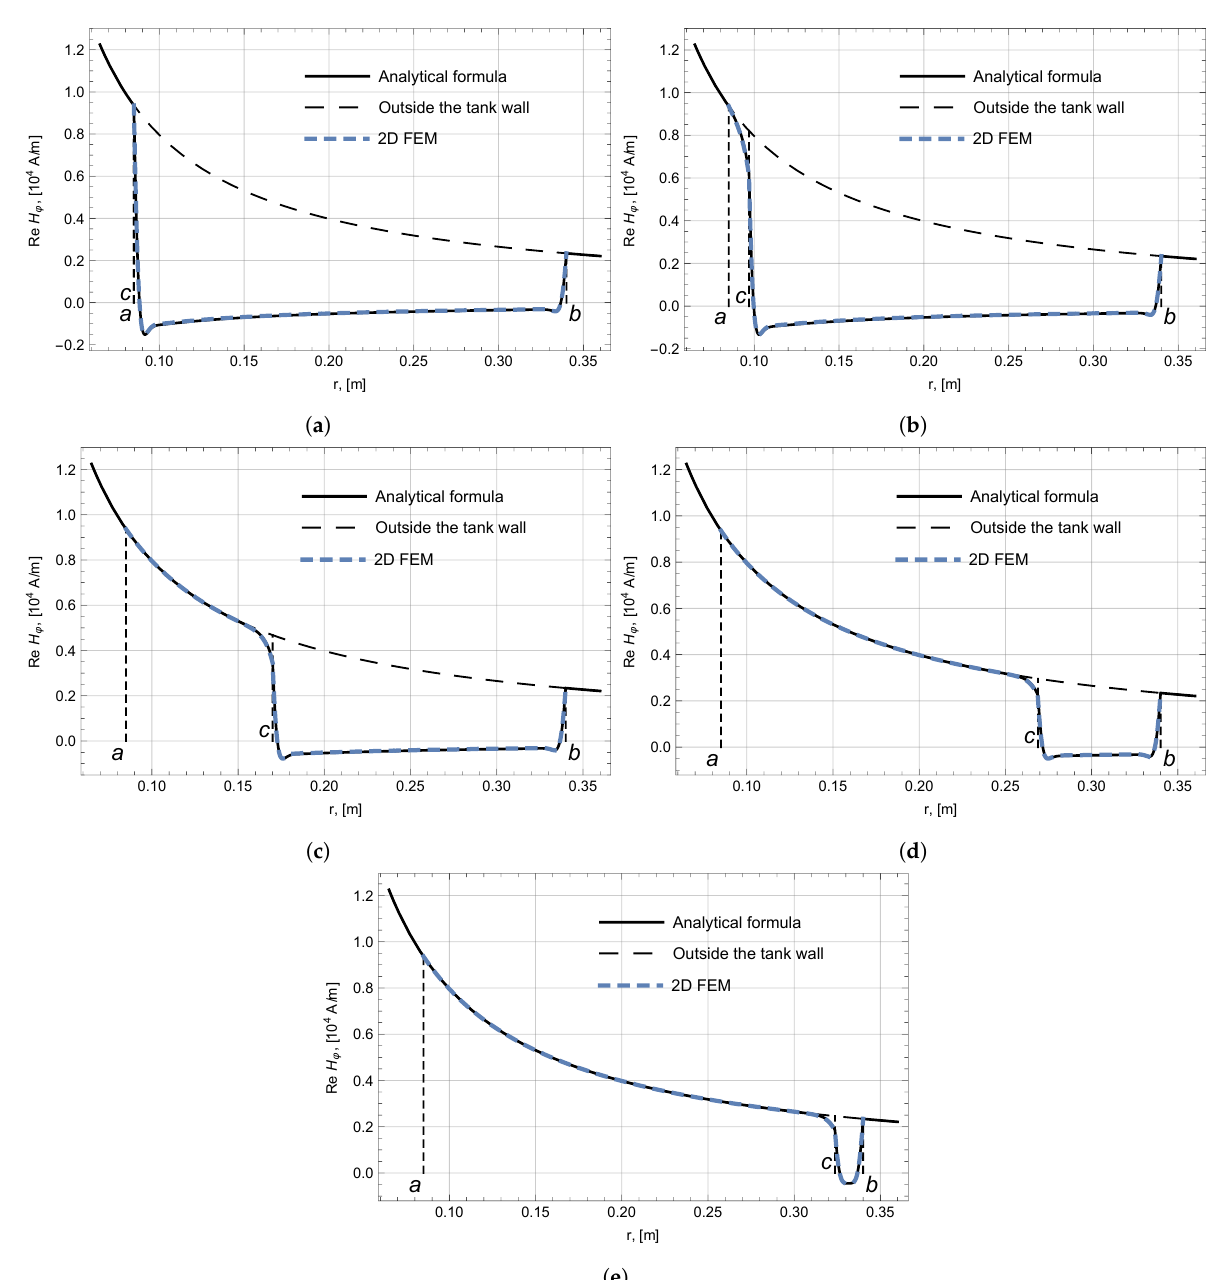
Figure 5. Magnetic field H ϕ evaluated at z = 0 and z = h /2. ( a ) Case c = a . ( b ) Case c − a = 11.914mm. ( c ) Case c − a = 85mm. ( d ) Case c − a = 183.89mm. ( e ) Case c − a =